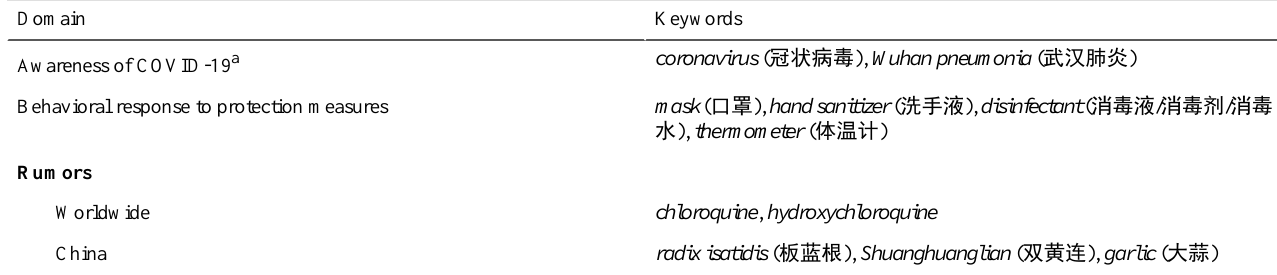
Table 1. Keywords searched for public awareness, behavioral responses, and rumors regarding the COVID-19